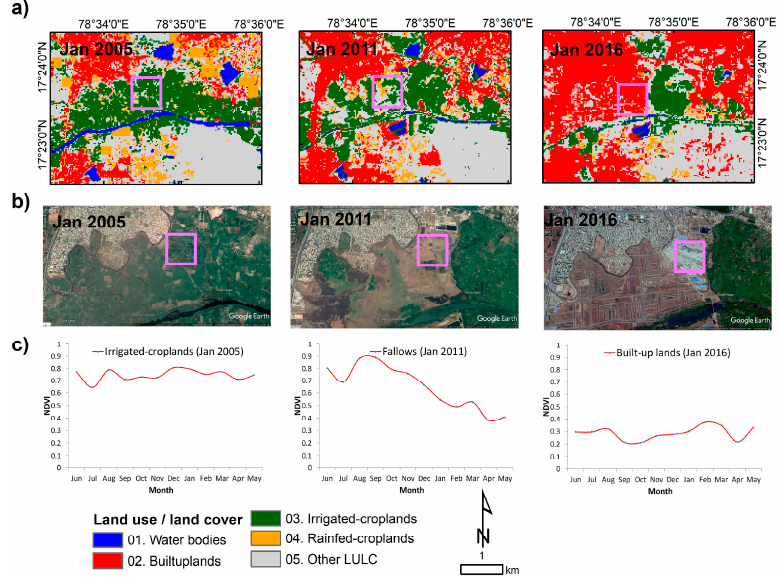
Figure 7. Example of temporal changes in 2005, 2011, and 2016. ( a ) The land-use/land-cover (LULC) classes; ( b ) true-color Google Earth imagery for the same LULC classes map; and ( c ) MODIS-derived NDVI signatures for 2005, 2011 and 2016.